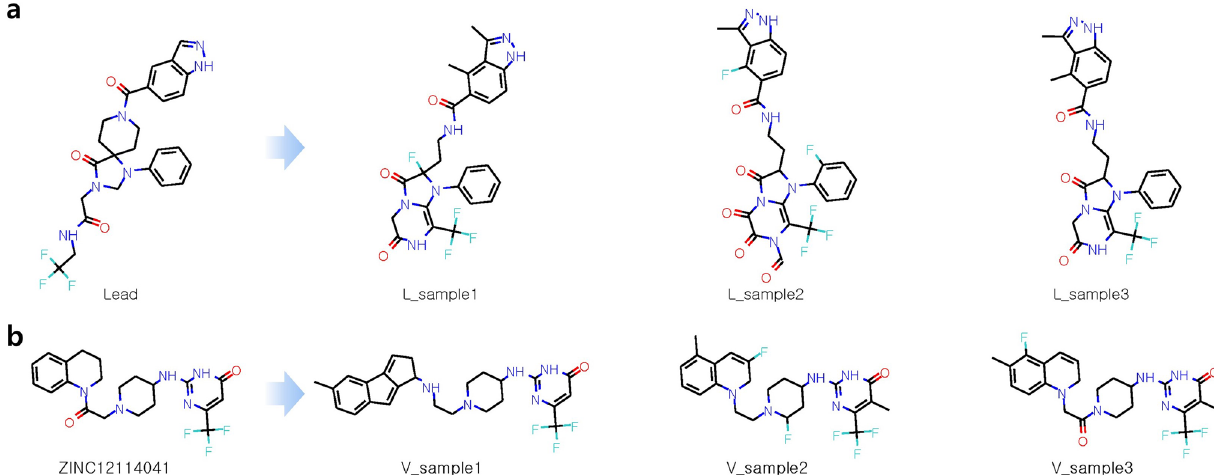
Figure 3. Samples from the inhibitors generated by the MORLD for the target DDR1. ( a ) Using the “Parent structure” shown in Fig. 1 of Zhavoronkov’s paper as the initial lead compound (Lead), DDR1 inhibitors were generated and three sample compounds are shown. ( b ) Three sample compounds generated from the initial compound ZINC12115041, which was identified by a simple virtual screening procedure for